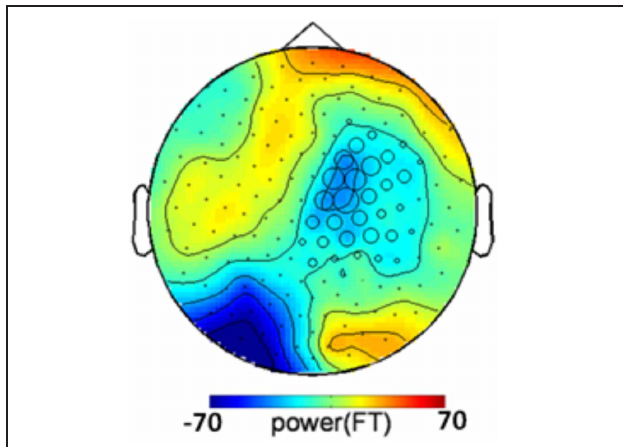
FIGURE 4 | Congruency-related cluster in grating-absent trials. Topographic map of the difference between congruent and incongruent grating-absent trials, averaged over the 130–350ms time window. Sensors recruited in the significant congruency-related cluster in grating-absent trials are indicated by an open circle whose diameter is proportional to the time during which the sensor is involved in the cluster. The topography of the congruency effect in grating-absent trials is different from the one obtained in grating-present trials ( Figure 3B ).